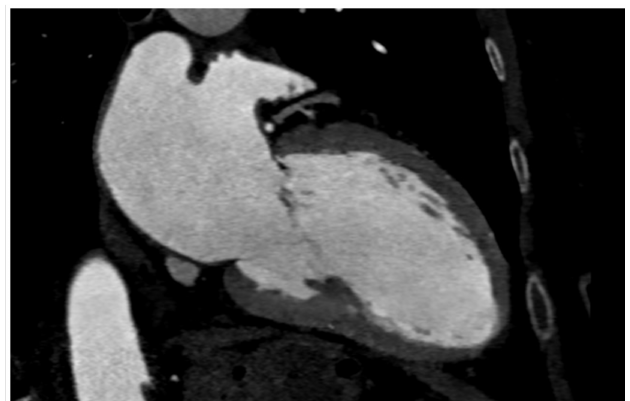
Figure 12. CT imaging for the assessment of left atrial appendage’s conformation. Example of “chicken wing”